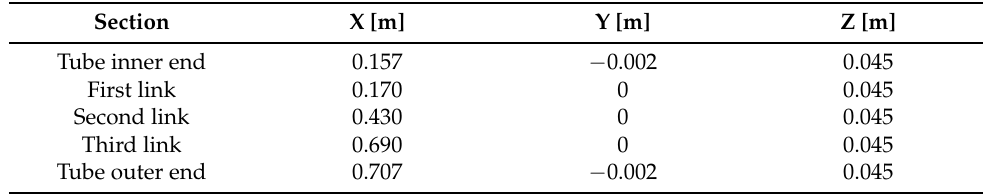
Figure 5. The spar and tube assembly. Table 4. Spar’s interest points